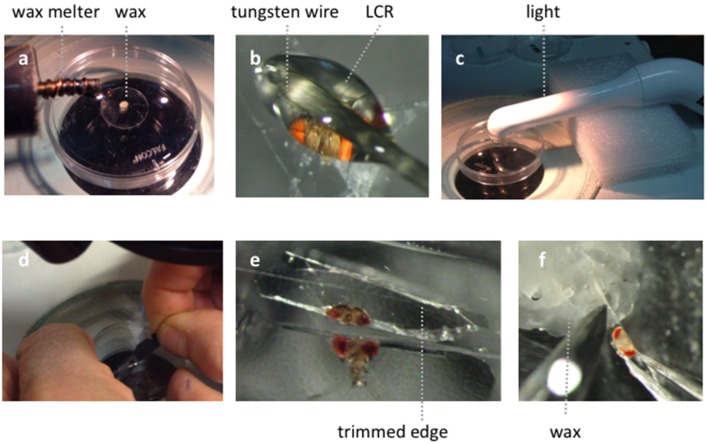
Illustration of the goggatomy procedure on a Drosophila head. (A) Melting a small piece of soft dental wax onto a circular cover slip. (B) Applying LCR to Drosophila head. (C) Curing light is place close to specimen. (D) Cutting through cured LCR. (E) Trimming embedded sections. (F) Placing chip in wax.